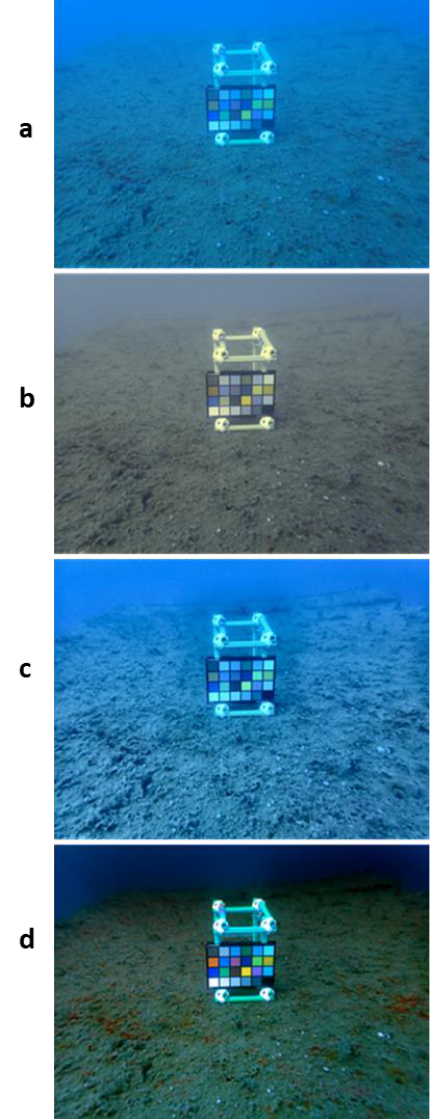
Figure 7. Correction results for Limassol Dataset: a) original image, b) Lab, c) CLAHE, d) proposed method (2nd